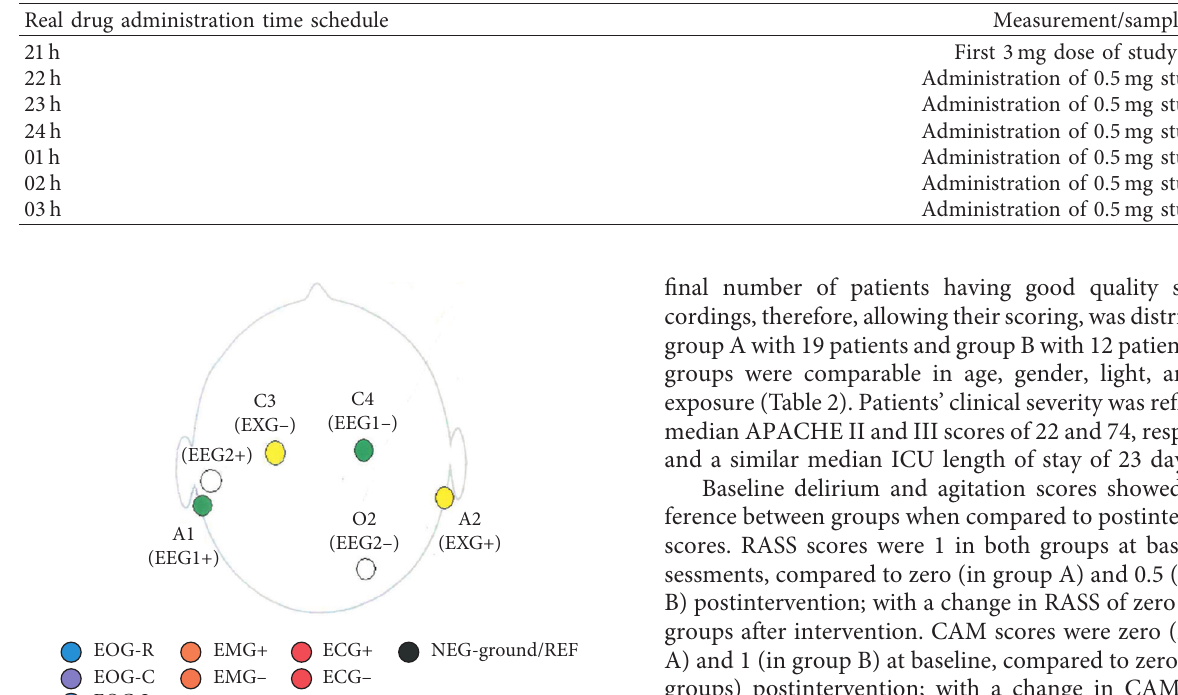
Table 1: Study drug administration regimen.